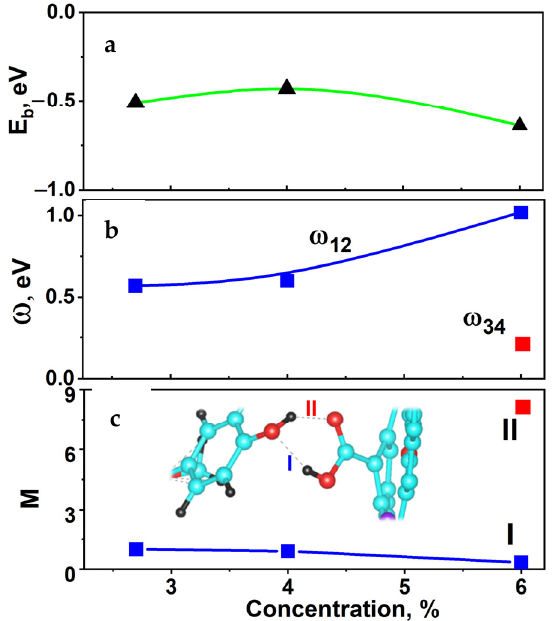
Figure 9. Concentration dependences of binding energy ( a ) E b , ( b ) driving frequencies, ( c ) and HIF-1 α release M.